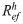
Estimation of Model PMAL in Period 1 (October/1995—September/2000).(a) observed incidence (O) and adjusted i (E), (b) m3/m, (c) Refh (h) and Refm (m), and (d) Ref=Refh×Refm.